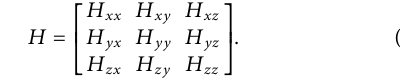
Frontiers in Earth